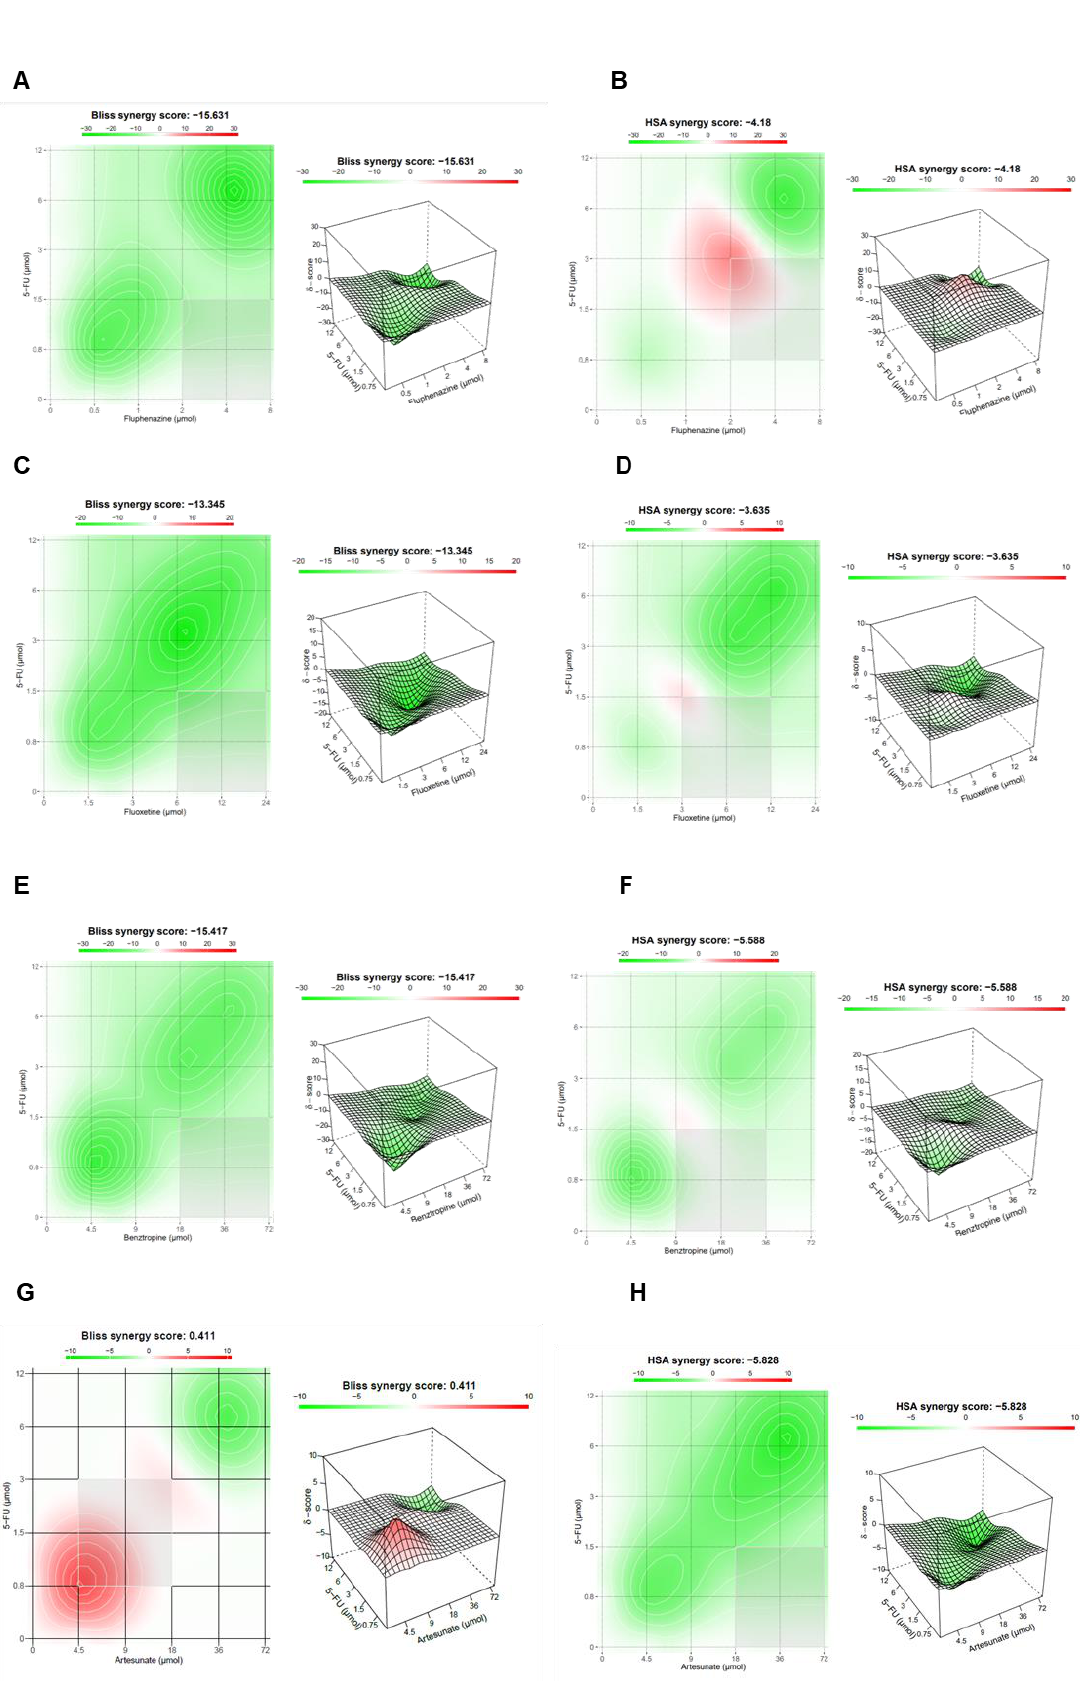
Figure 10. Bliss ( left ) and HAS ( right ) synergy plots of 5-FU plus fluphenazine ( A , B ), fluoxetine ( C , D ), benztropine ( E , F ) and artesunate ( G , H ).